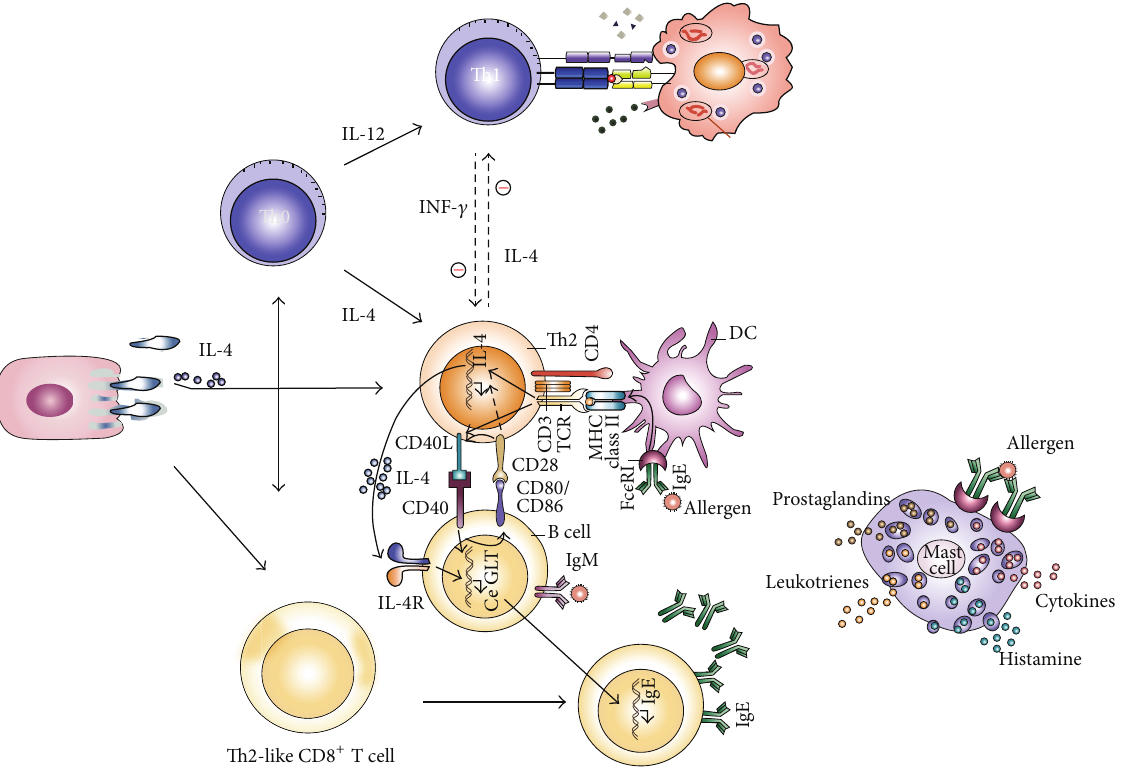
Figure 6: Proposed role of Mycoplasma pneumoniae in type I hypersensitivity. The adherence of MP to respiratory ciliated epithelium causes the production of cytokines and recruitment of lymphocytes and other immune cells. These cytokines influence the Th1/Th2 balance, which leads to the elevated secretion of IL-4 by Th2 cells. The production of IgE antibodies is enhanced by IL-4 receptor signals. Subsequent crosslinking of IgE on basophils and mast cells triggers their degranulation and the release of active